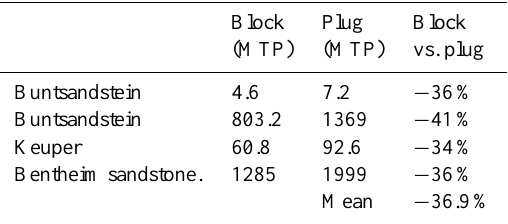
Table 2. Comparison of TinyPerm measurements (MTP) from four “unconfined” rock blocks (10 × 10 × 10 cm) and the corresponding 1-inch sample plugs, representing permeability orders of 10 0 , 10 1 , 10 2 , and 10 3 mD. Measured permeabilities are 34–41% lower on unconfined samples than on plug samples (mean: − 36.9%).